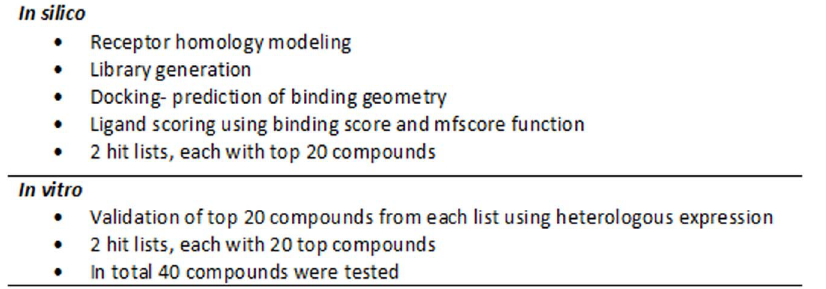
Figure 1. The experimental study design. List of procedures used in this study for in silico and in vitro approach of deorphanizing olfactory receptors.